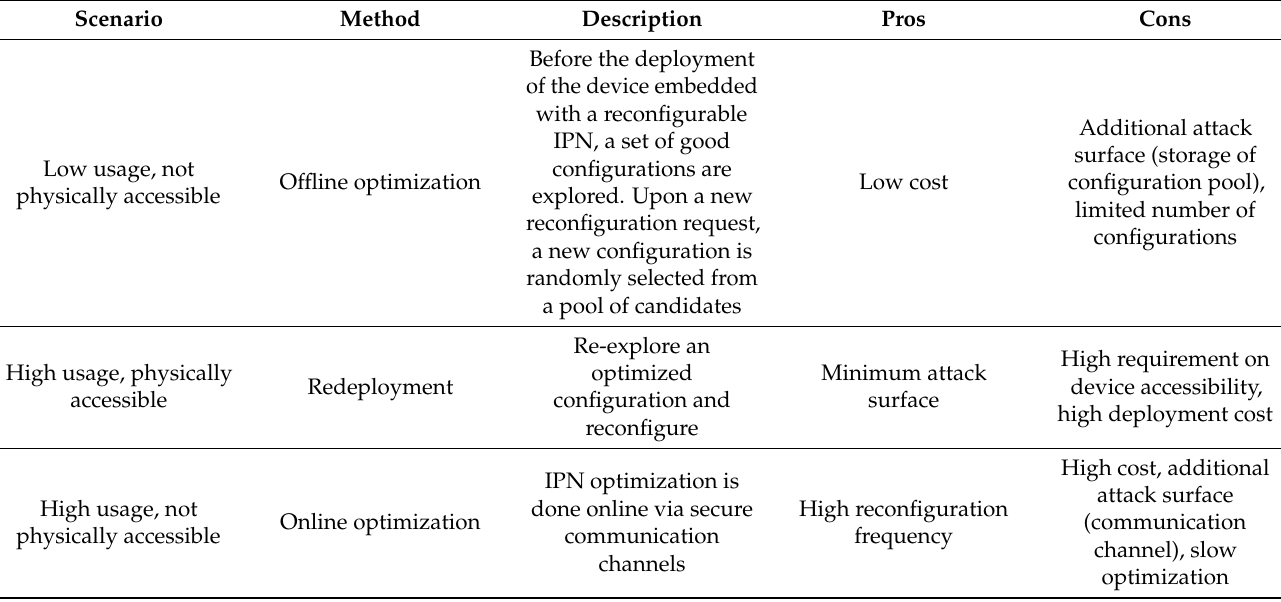
Table 9. Reconfigurable IPN optimization choices in different